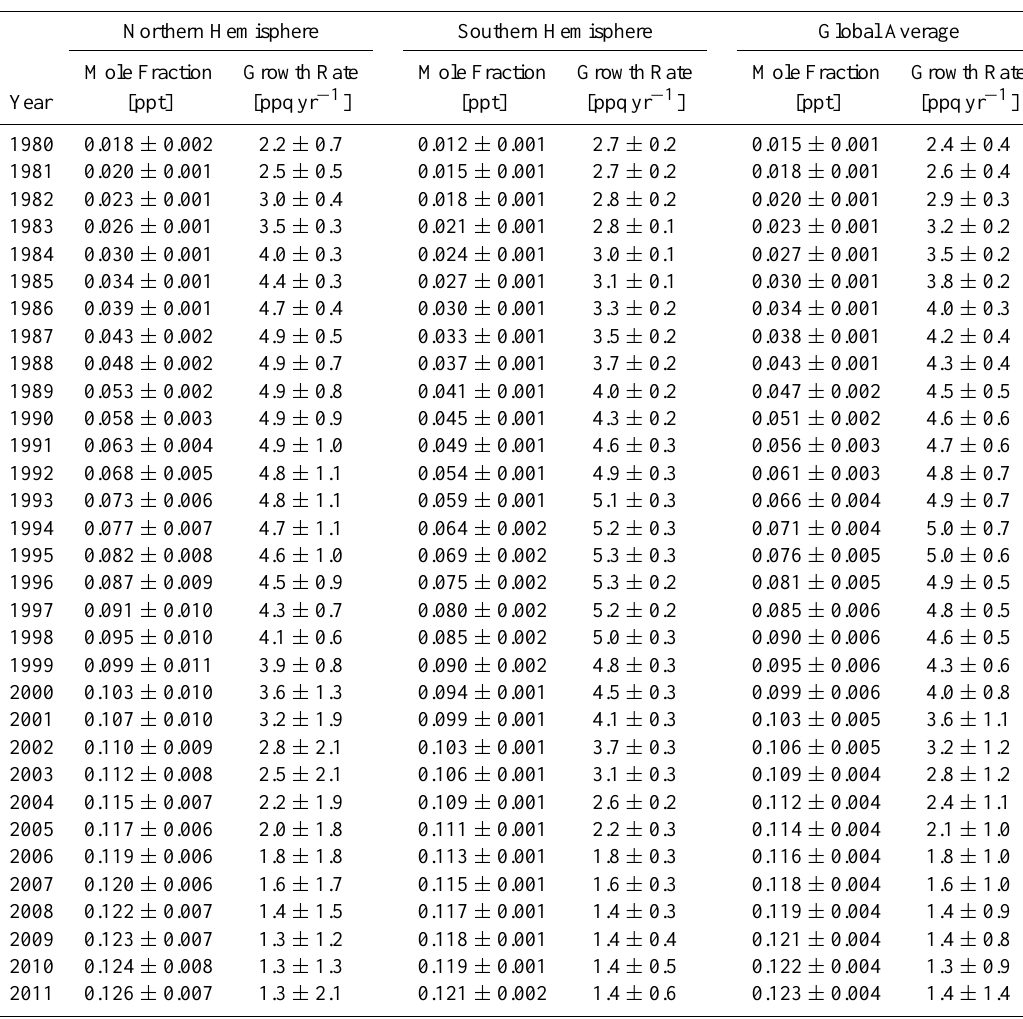
Table 4. Northern and Southern Hemisphere and Global Average Annual Mean Mole Fractions and Growth Rates and Associated Uncer- tainties 1980-2011 for C 5 F 12 .